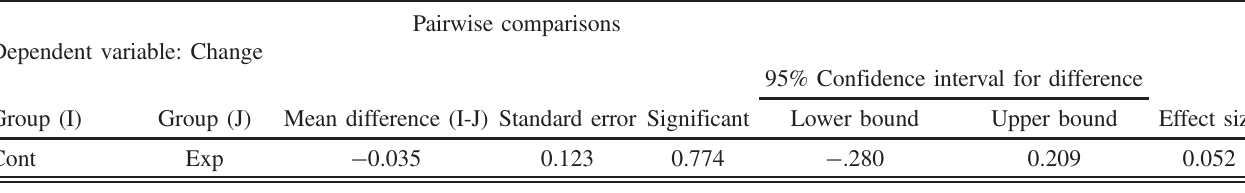
TABLE XIV. A pairwise comparison between the experimental group and the control group (end of the winter 2015 semester) for the attainability of truth factor in winter 2015.